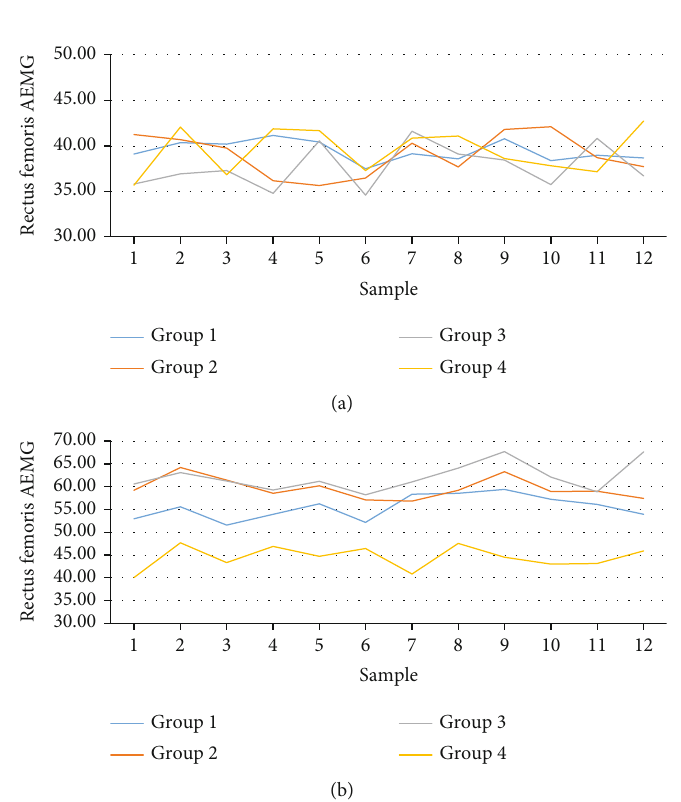
Figure 7: Changes of myoelectric value of rectus femoris before and after treatment. (a) The average electromyographic value of the rectus femoris before treatment in each group. (b) The average myoelectric value of the rectus femoris muscle after treatment in each